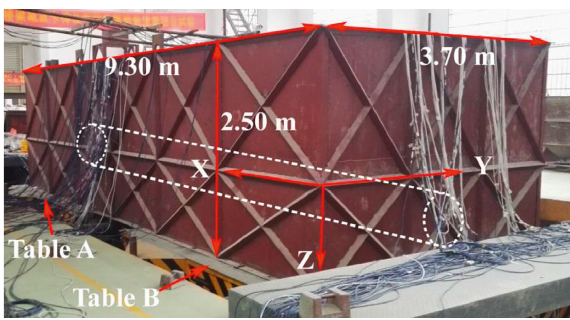
Figure 2: The soil container.